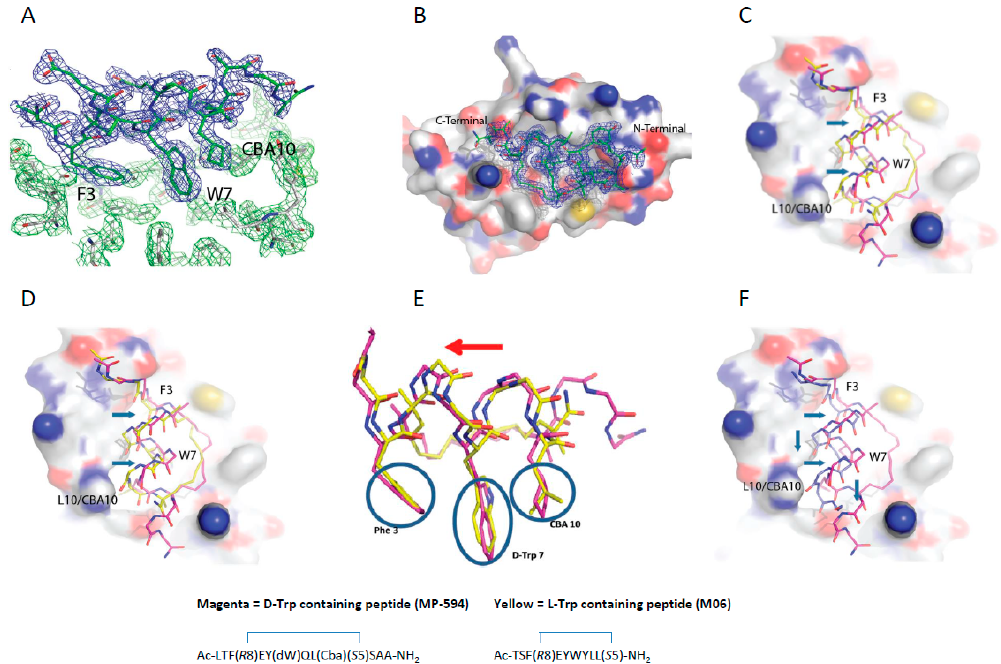
Figure 5. ( A ) The three critical residues (F3, D-Trp 7 , and Cba 10 ) responsible for the interaction of the peptide with Mdm2 project into a hydrophobic groove on the surface of Mdm2. 2Fo-Fc map for ATSP-7041 variant with a W 7 to d -Trp substitution (MP-594) peptide is shown in blue and the 2Fo-Fc map for Mdm2 is shown in green (1.5 σ ). ( B ) Surface representation of Human Mdm2 (6–125) in complex with MP-594. The 2Fo-Fc electron density map for MP-594 is shown in blue mesh (1.5 σ ). ( C ) Alignment of MP-594 (magenta) with the M06 stapled peptide (chain C from PDB ID: 4UMN, yellow) ( D ) and the SAH-8 stapled peptide (chain B from PDB ID: 3V3B, cyan), both respectively in complex with Mdm2, highlighting the translation (blue arrows) of MP-594 across the peptide binding groove. ( E ) Overlay of MP-594 and M06, demonstrating that the d -Trp 7 sidechain of MP-594 occupies the same volume of space as the Trp 7 in M06 without perturbing the spatial positions of the other critical side chains in relation to each other or the overall α -helical fold of the constrained peptide. Only a global shift in register of the whole peptide occurs to maintain these critical interactions in their optimal positions with Mdm2. ( F ) Alignment of MP-594 (magenta) with the linear pMI N8A peptide (chain B from PDB ID: 3LNZ, blue), both in complex with Mdm2, where gross di ff erences can be observed between both molecules in terms of displacement along and across the Mdm2 binding pocket (blue arrows).